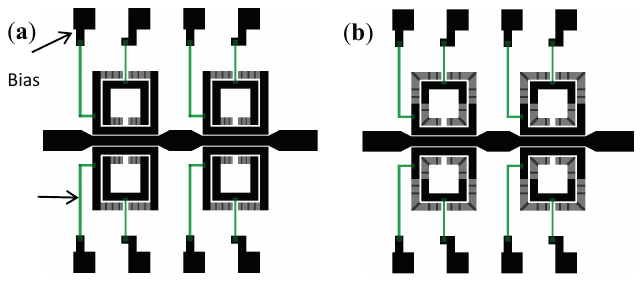
Figure 13. Tunable stopband filters based on square-shaped short ( a ) and long ( b ) cantilever-type SRRs, and measured transmission coefficients for the extreme switching states ( c ). SRR side length is 1200 μ m, ring width 150 μ m and ring separation 30 μ m. The separation between the SRR and the microstrip line is 25 μ m. The actuation voltages are applied to the rings through the bias pads and high resistive lines (HRLs). Solid lines correspond to the filter of (a); dash-dotted lines correspond to the filter of (b). Actuation voltage is 30 V. From [22], reprinted with